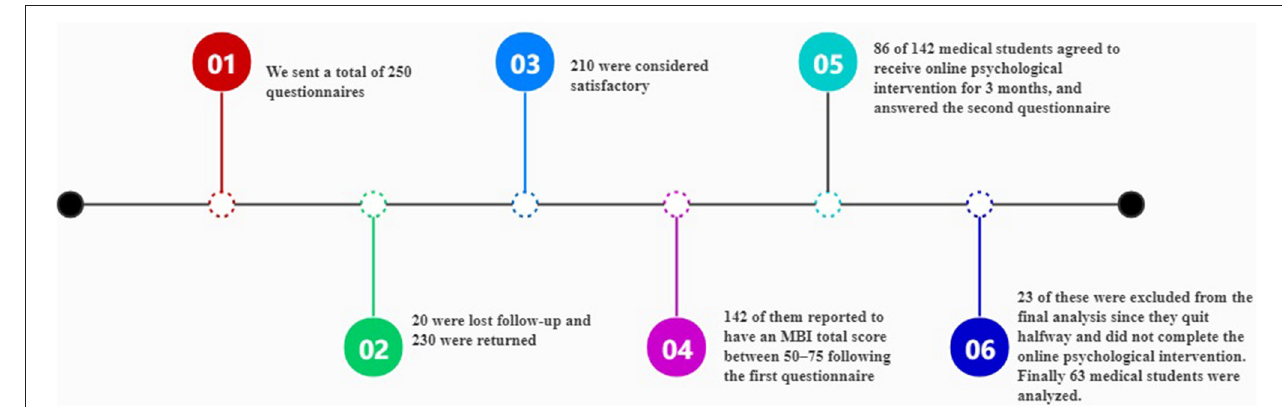
FIGURE 1 | Timeline of the